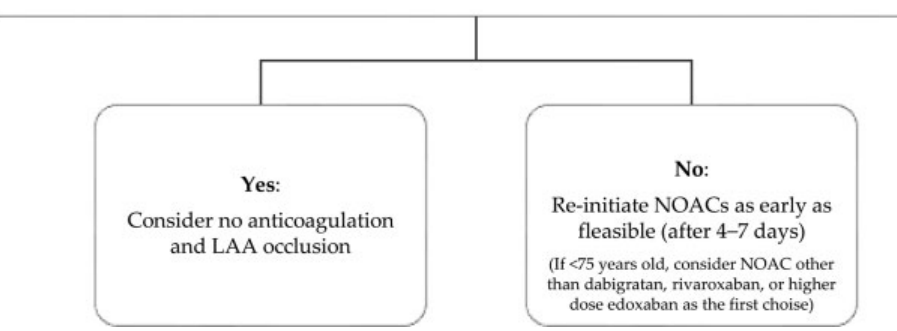
Fig.1 Managementof anticoagulant therapy after major gastrointestinal bleeding. GI, gastrointestinal; LAA, left atrial appendage; NOAC, non – vitamin K antagonist oral anticoagulants; PCI, percutaneous coronary intervention.